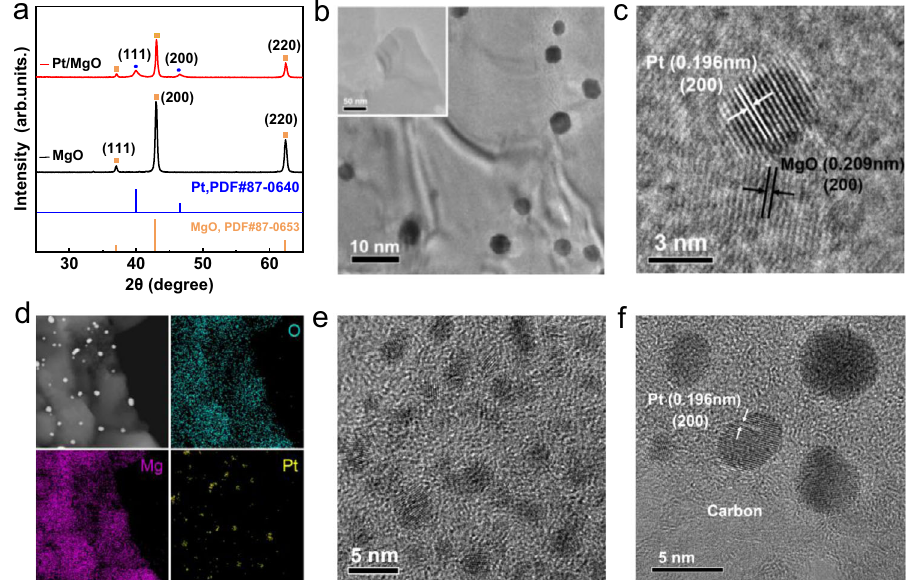
Fig. 1 Structural characterizations. a XRD patterns of Pt/MgO and MgO. b TEM image of Pt/MgO, the inset shows the MgO nanosheet. c HRTEM image of Pt/MgO. d Elemental mapping images of Pt/MgO. e TEM and f HRTEM images of